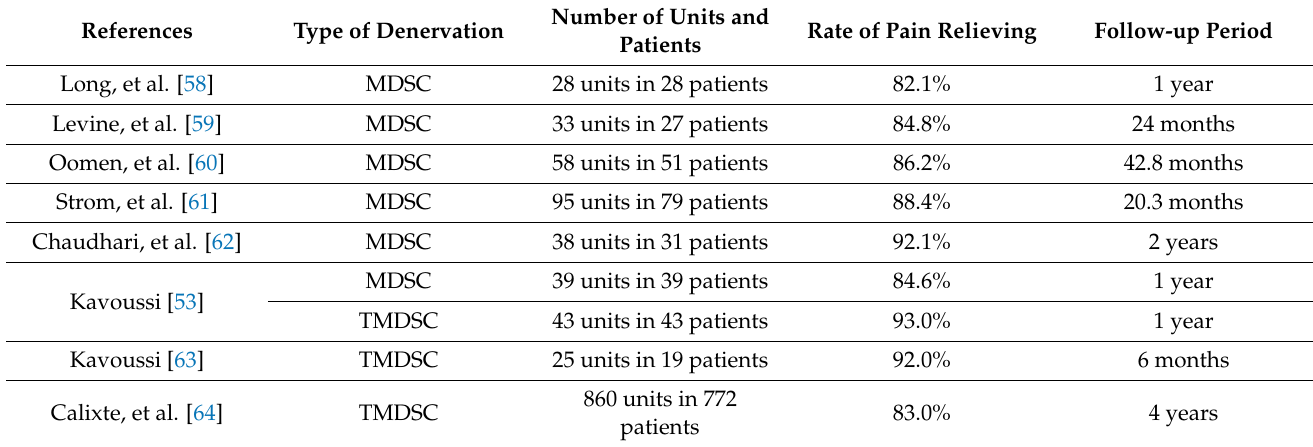
Table 3. Successful pain relieving rates of MDSC and